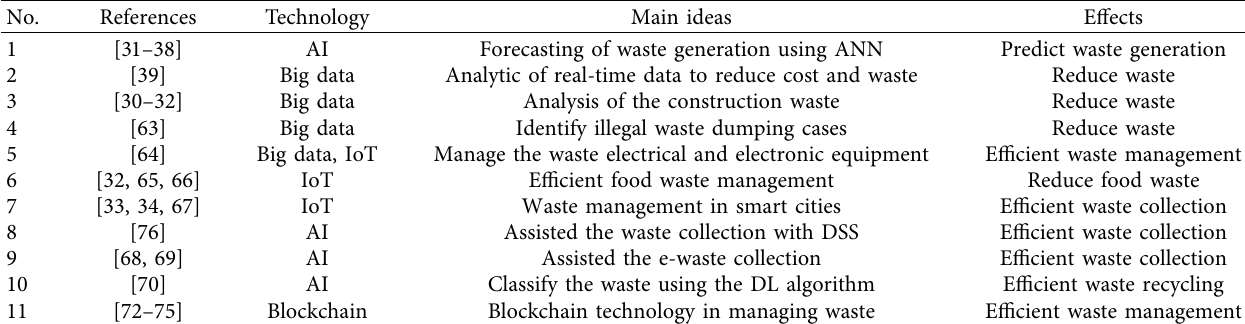
Table 3: Applications of digital technology in waste management and